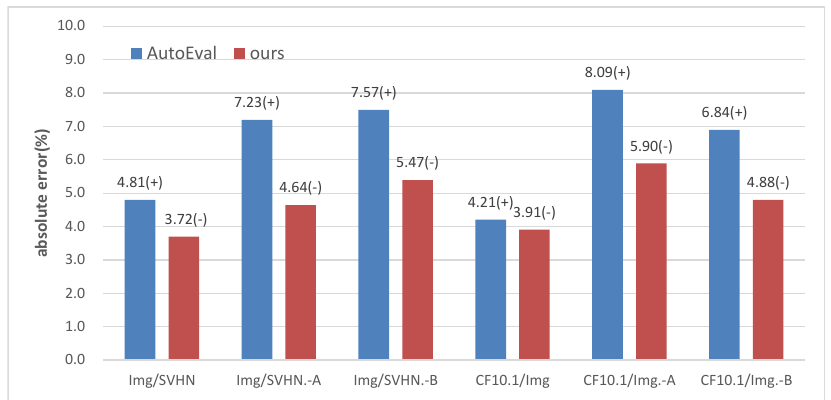
Figure 5. The graph shows the comparison of the error rate between our proposed method and AutoEval on transformed test sets. Img represents the ImageNet dataset, and CF10.1 represents the CIFAR10.1 dataset. For group A images, we applied cutout, while for group B, we used shear and changed the hue. ( − )/(+) indicates that the predicted accuracy is lower/higher than the ground- truth accuracy. As shown in the figure, our method always outperforms traditional AutoEval on transformed